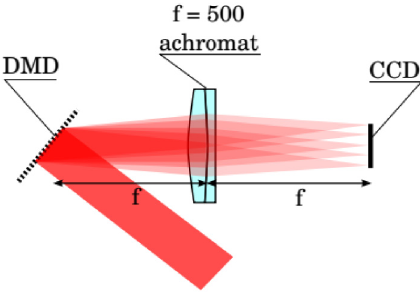
Fig. 2. Setup of the Fourier plane imaging of the DMD device. The CCD sensor is placed in the Fourier Plane of the lens, i.e. on the focal plane of the lens, symmetrically with respect to the DMD.